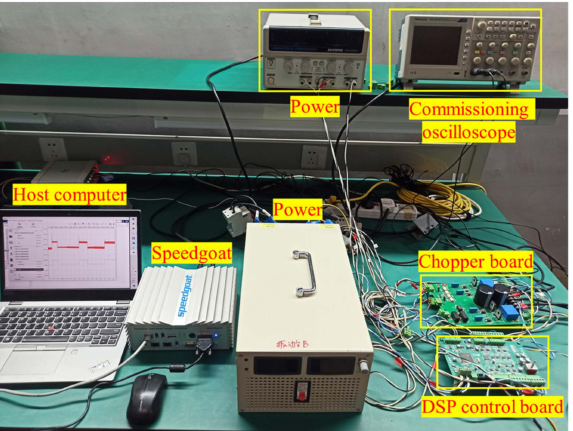
Figure 14. Schematic diagram of control circuit module of magnetic suspension system experimen- tal platform.